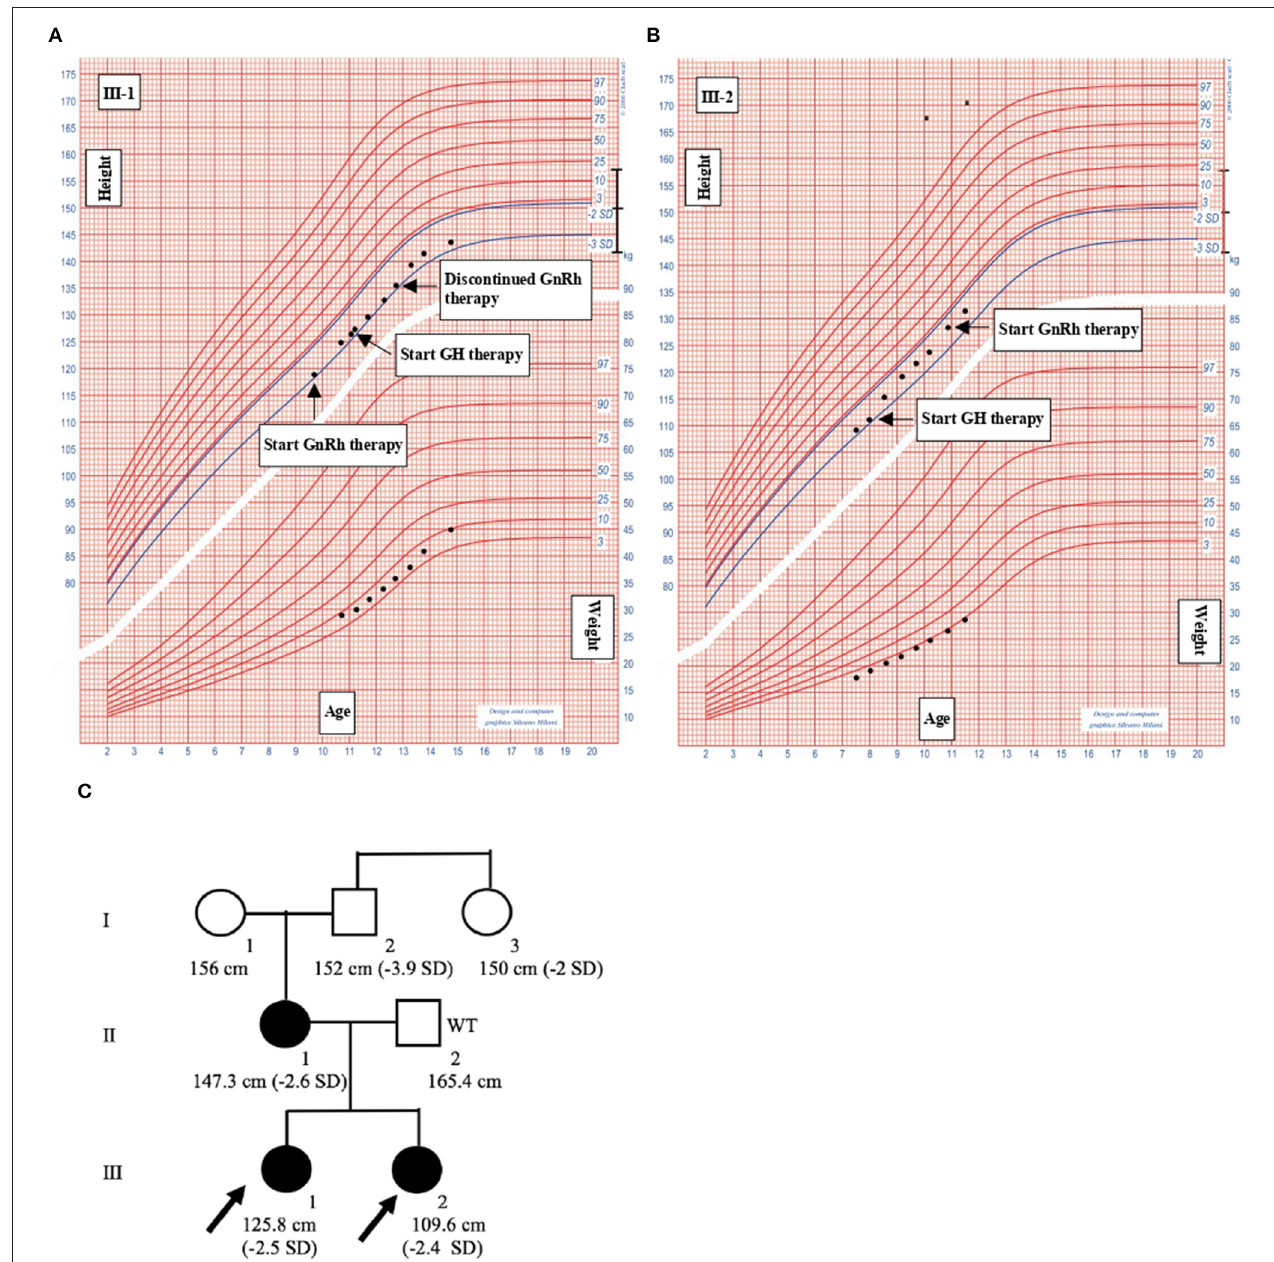
FIGURE 2 | Clinical informations of the family members. (A) III-1. (B) III-2. Growth charts of the probands. Heights and weights are shown as black points. GH, Growth hormone; GnRH, gonadotropin-releasing hormone. (C) Pedigree of the family with familiar short stature. Shaded symbols indicate patients with stature below 2 SD; empty symbols with “WT” (Wild Type) are family members without mutations; empty symbols indicate family members who have not undergone ACAN sequencing.